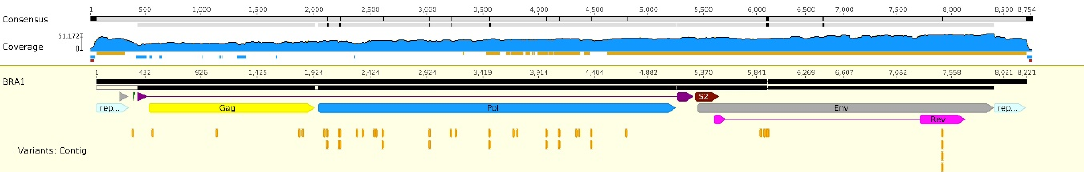
Figure 2. Representative genome of EIAV BRA1. Genome annotation shows the variant distribution, marked below in yellow. Coverage is represented in blue, and identity is represented in dark yellow.